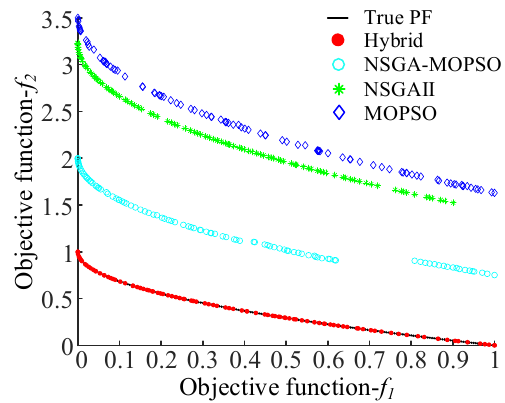
Figure 6. Comparison results for ZDT4.